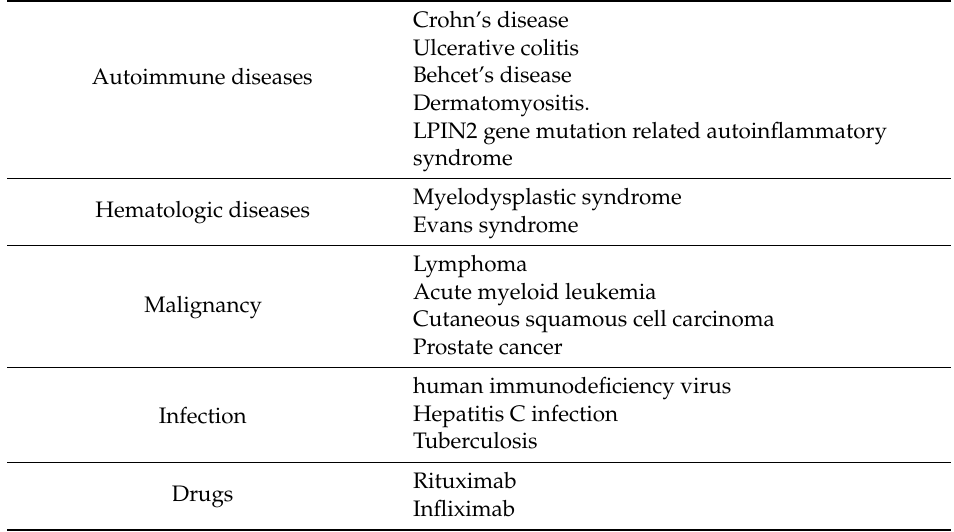
Table 1. The systemic diseases associated with genital pyoderma gangrenosum